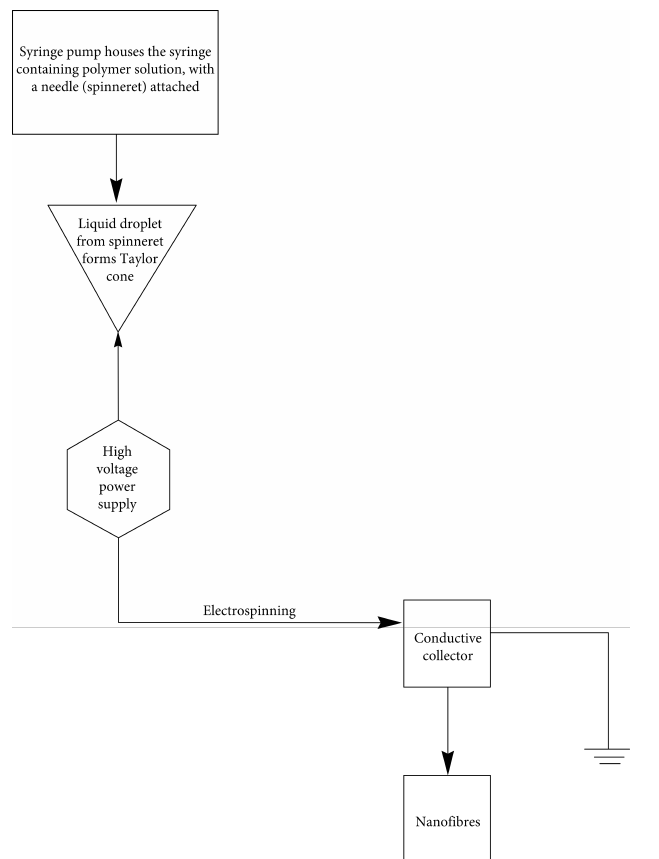
Figure 4. Schematic illustration of the mechanism of the traditional electrospinning method used to create